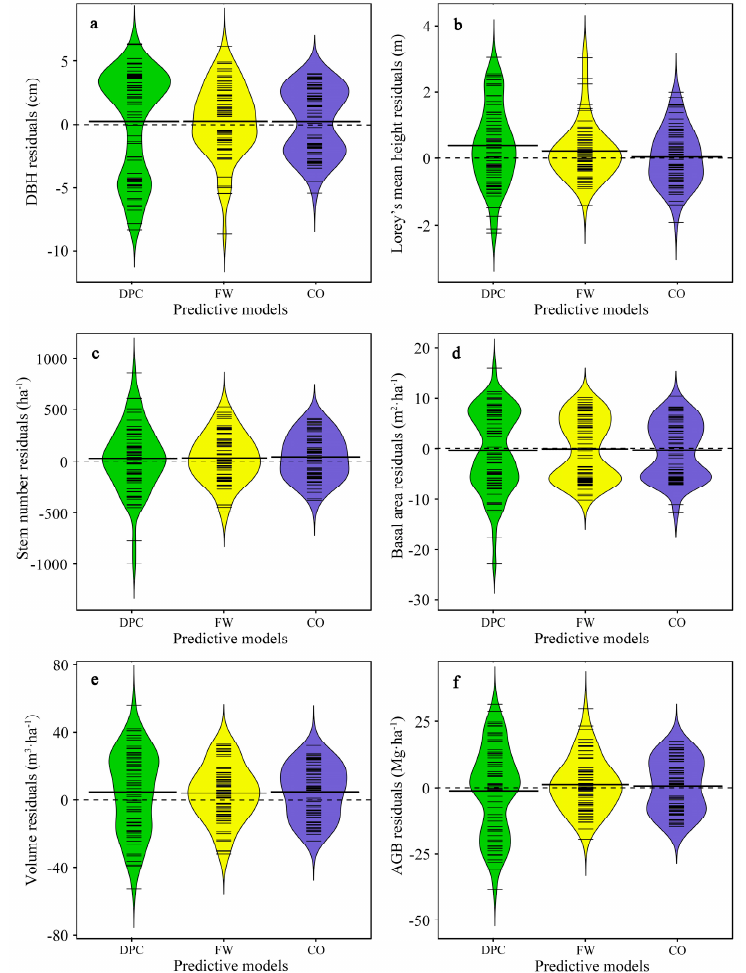
Figure 8. The residuals of six forest structural parameters predicted by DPC based models (DPC), DPC and FW based models (FW), and combo models (CO) which including both LiDAR and hyperspectral metrics, i.e., forest structural parameters: ( a ) DBH; ( b ) H L ; ( c ) N; ( d ) G; ( e ) V; and ( f ) AGB.